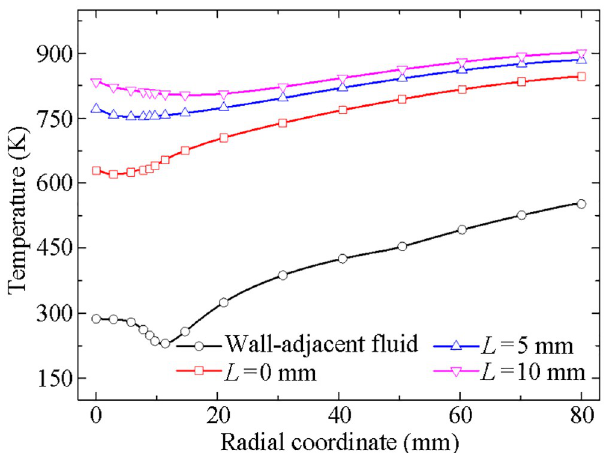
Fig 11. Comparison of the temperature distributions of the defined three different radial